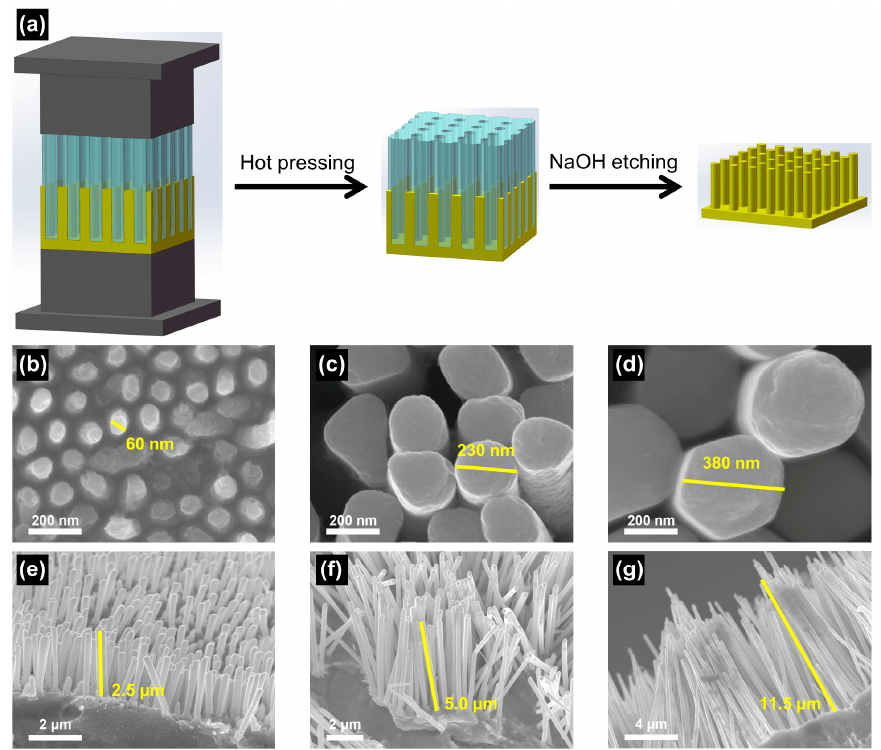
Figure 1. ( a ) Synthetic process of Zn NWA. Zn NWA that is prepared using AAO templates with ( b ) 50 nm, ( c ) 200 nm, and ( d ) 400 nm nominal pore size. Zn NWA that is prepared using a 200 nm AAO template with a hold time of ( e ) 20 min, ( f ) 60 min, and ( g ) 120 min.